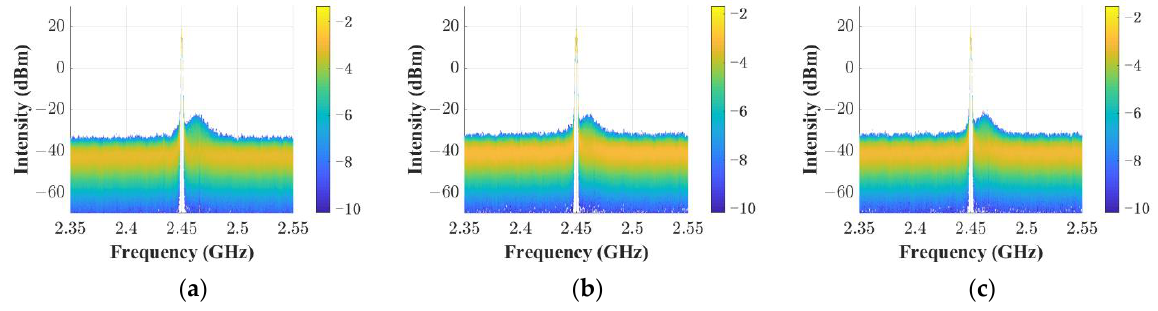
Figure 7. Measured DPX spectra of the magnetron with injecting amplitude at ( a ) 0.001, ( b ) 0.002 and ( c ) 0.003 under the power supply ripple S = 1%.